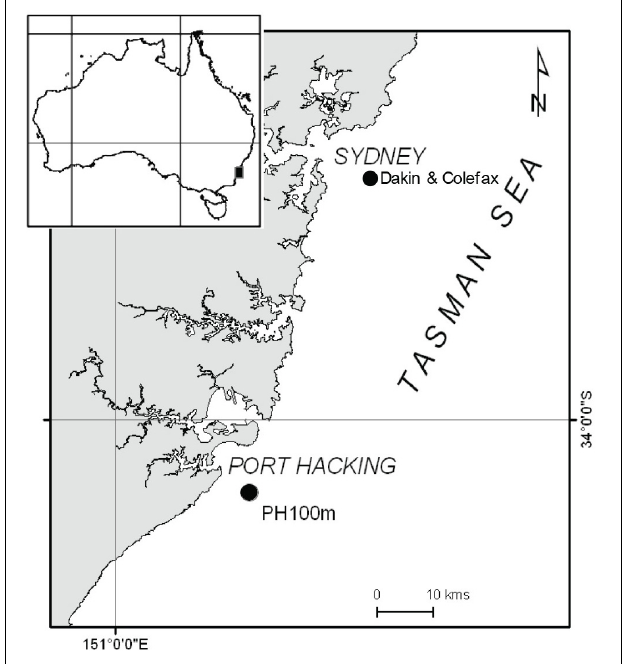
FIGURE 1 | Map of study area showing southeast Australia (inset) and the coastal monitoring stations of Dakin and Colefax (DC) and Port Hacking 100 m (PH 100m ) indicated by black